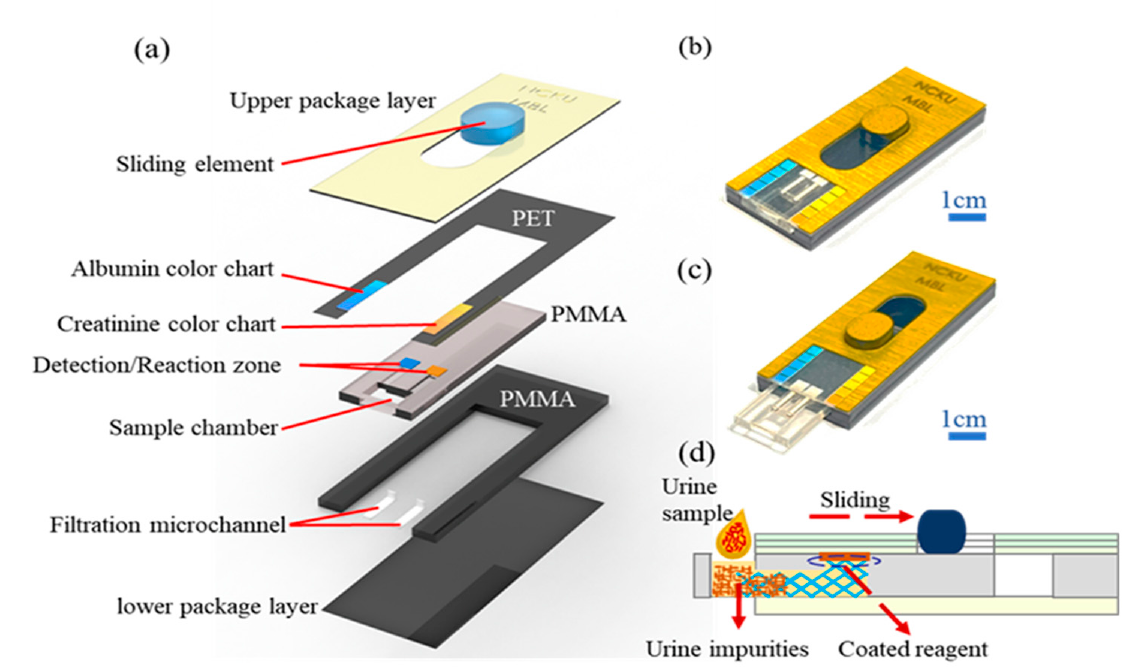
Figure 1. ( a ) Detailed structural arrangement of sliding microchip for simultaneous ALB and CRE detection. ( b , c ) Schematic representations of sliding microchip in retracted and extended conditions. ( d ) Cross-sectional view of sliding microchip in retracted condition.